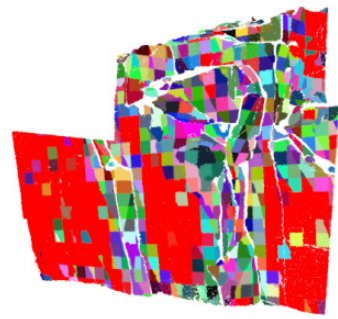
Figure 2. Supervoxel segmentation in the boundary. Supervoxel patches are